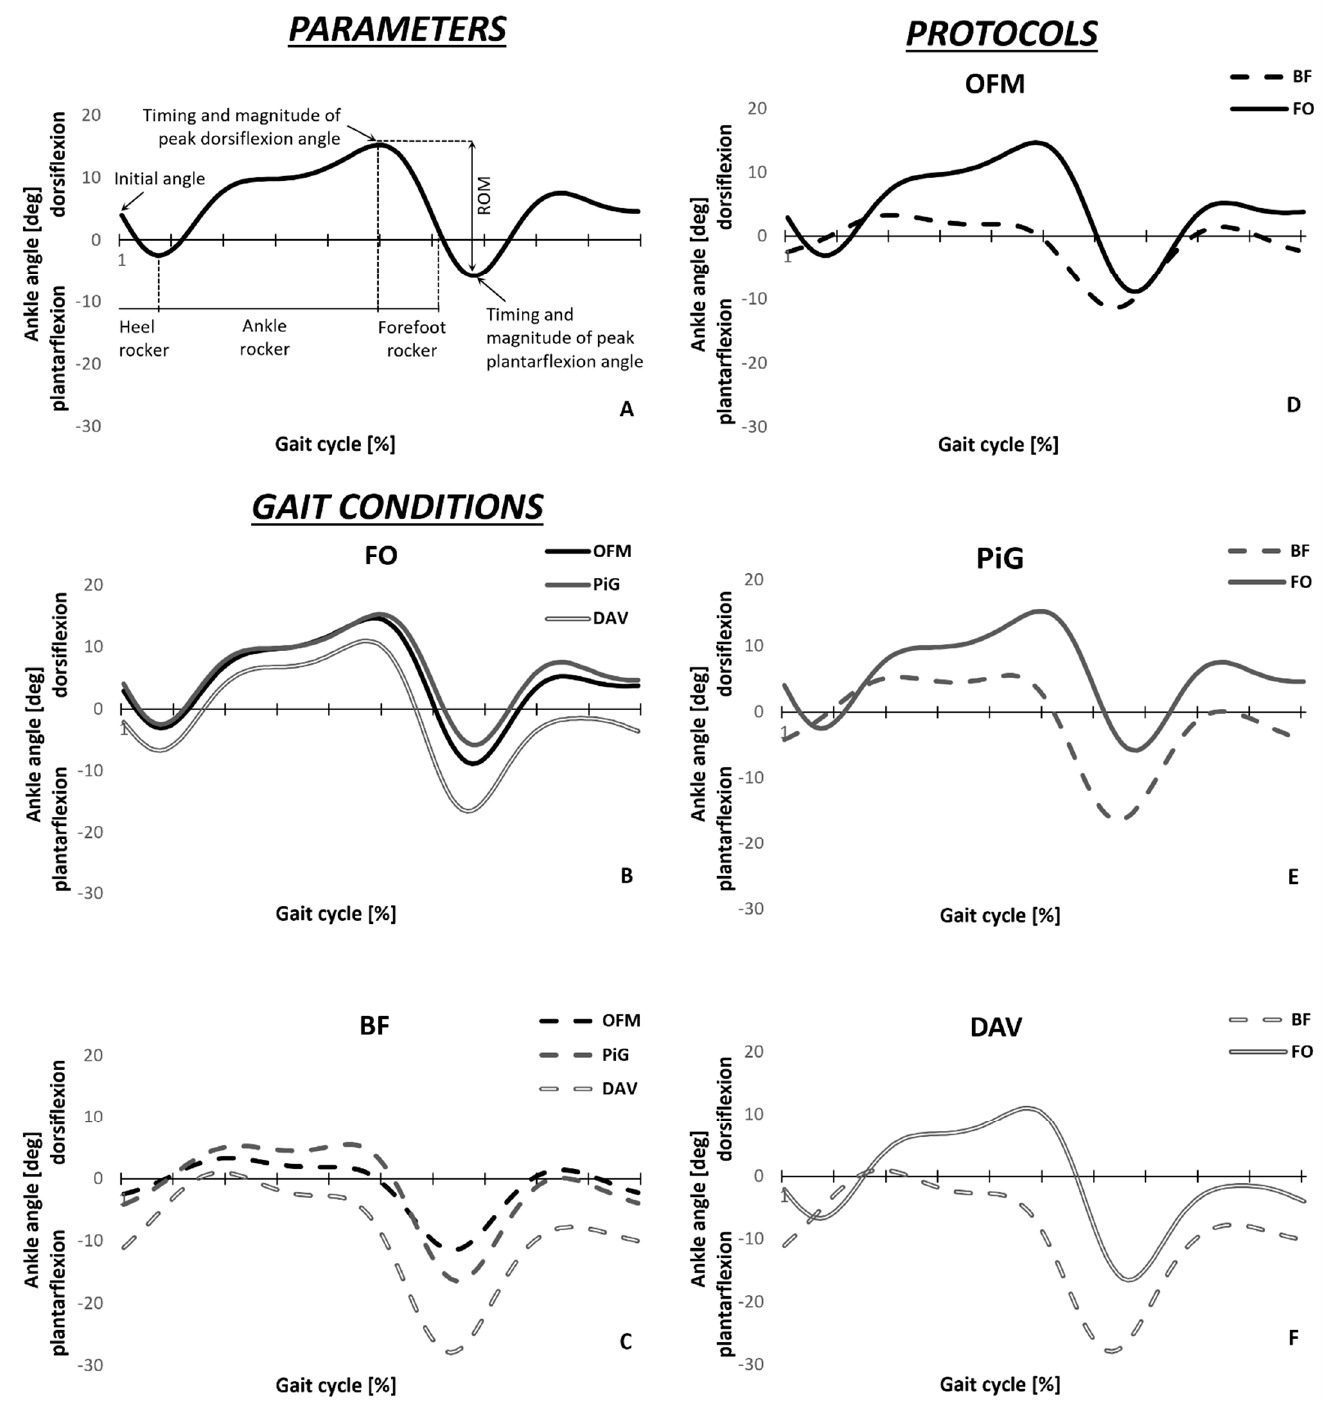
Figure 2. ( A ): Graphical representation of calculated parameters on a representative kinematic trace obtained using OFM. In all other panels the mean ankle kinematics of the participants’ representative trials estimated using OFM (black), PiG (dark gray), and DAV (dark gray contoured) for FO (solid) and BF (dashed) conditions is represented. In ( B , C ), curves from different models are compared for FO (solid) and BF (dashed) conditions, respectively. In ( D – F ), curves from different conditions are compared for OFM (black), PiG (dark gray), and DAV models, respectively. To verify whether the main effects of using mono- or multi-segment foot models existed and whether the differences between models were specific to the presence of ITW gait deviations, i.e., whether interactions between models and walking conditions existed,